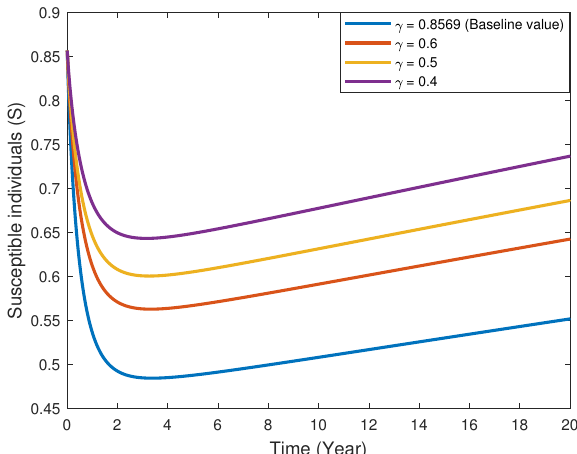
Figure 15. Behavior of S class for different γ values.